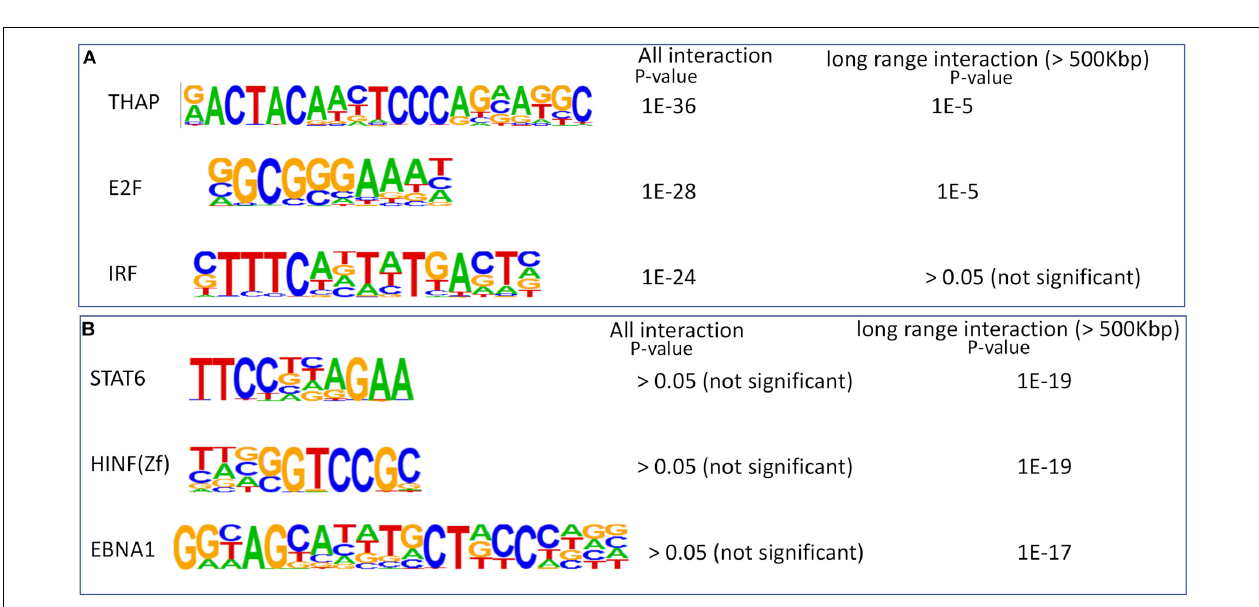
Frontiers in Genetics |